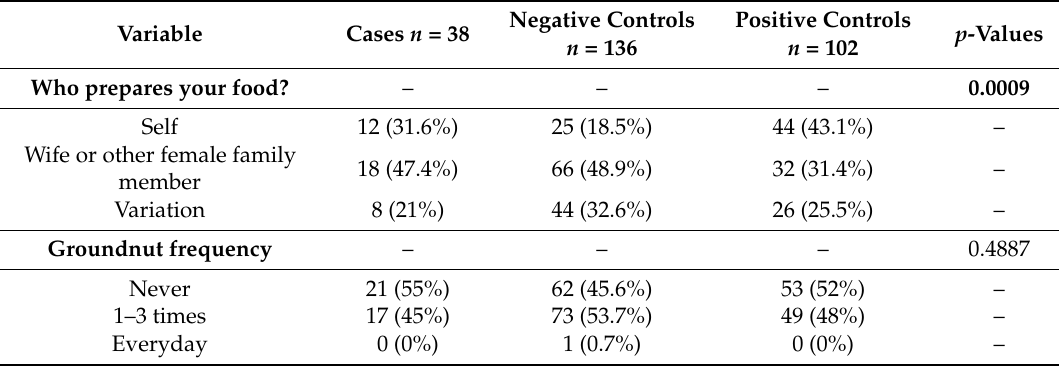
Table 3. Food preparation and consumption habits of